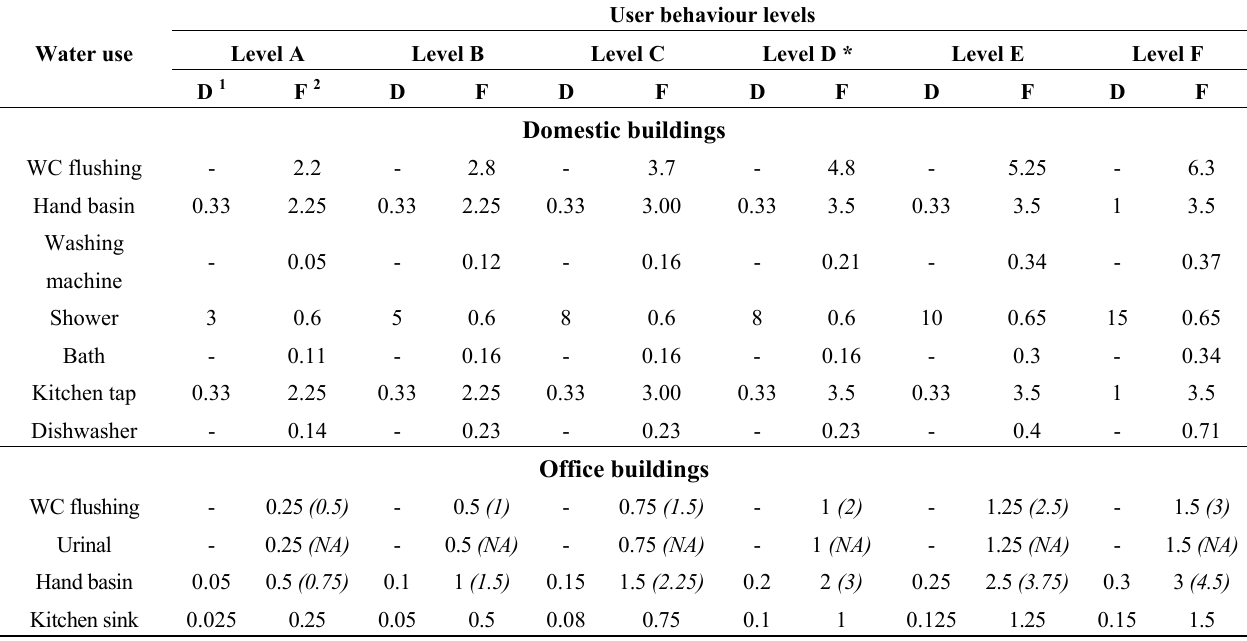
Table 4. Assumed user behaviour in domestic and office buildings: Level A (best performance) to Level F (worst performance). Italics show where water use by females differs from that of